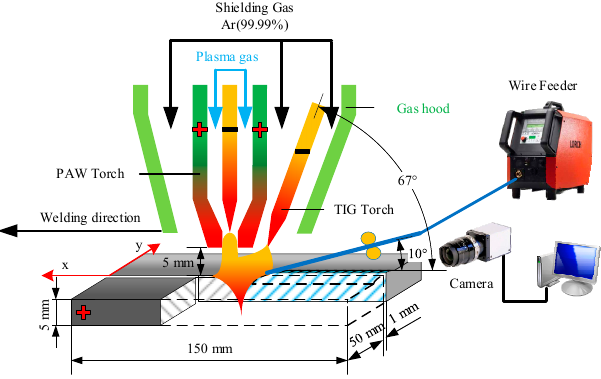
Figure 1. Proposed PTCAW processing system.